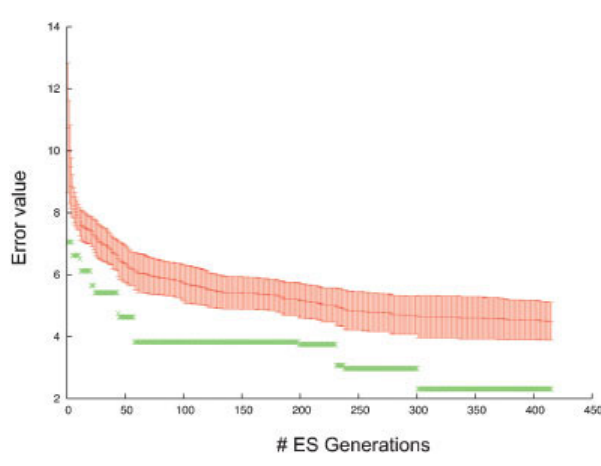
Figure 14. Error evolution PC model . Error evolution during the optimization process of the PC model. Mean error value ± standard deviation in every generation is in red. The error value of the best individual is in